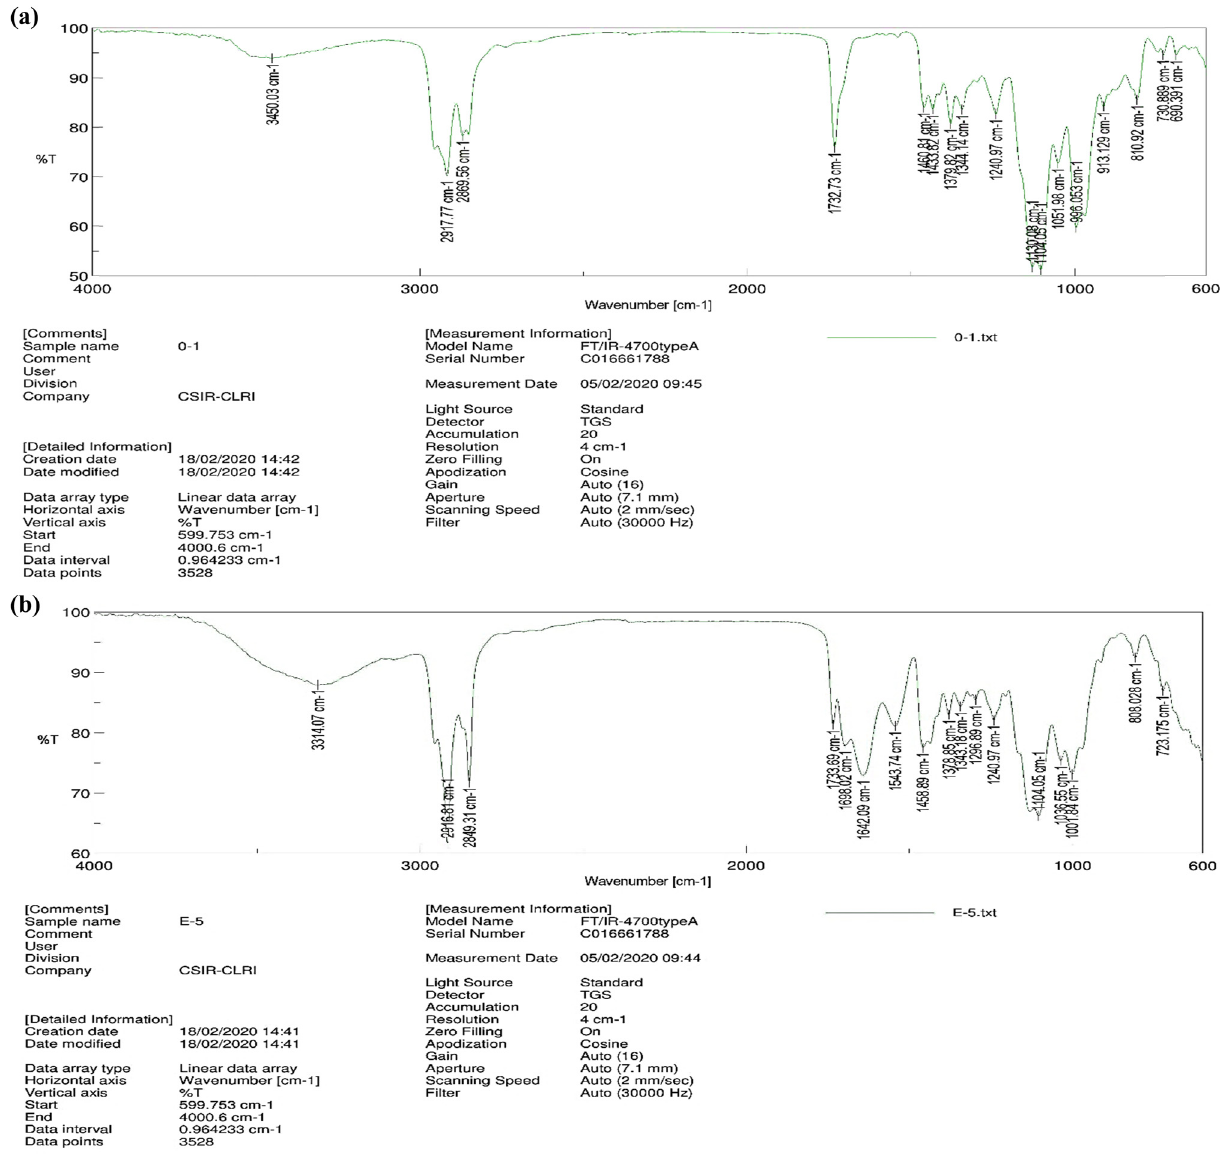
Figure 47: ( a ) FTIR spectra of neat recycled EVA polymer without any leather fi bers and ( b ) FTIR spectra of leather bu ffi ng dust/recycled EVA polymer